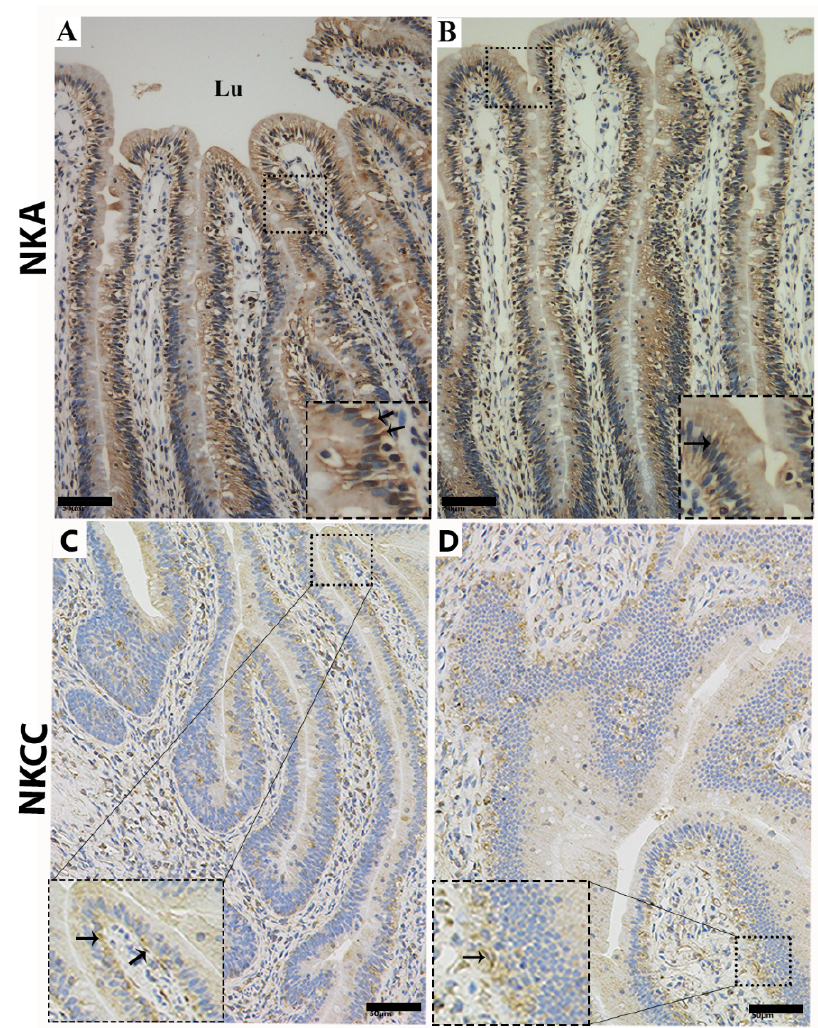
Figure 5. Immunohistochemical localization of Na + / K + _ ATPase (NKA) and Na + / K + / 2Cl − cotransporter (NKCC) in the mucosal surface of the small intestine of P. sinensis . NKA and NKCC immunoreactivity showed positive expression in the mucosal surface (black arrow). Lu: lumen. Scale bar = ( A – D ) 50 µm.